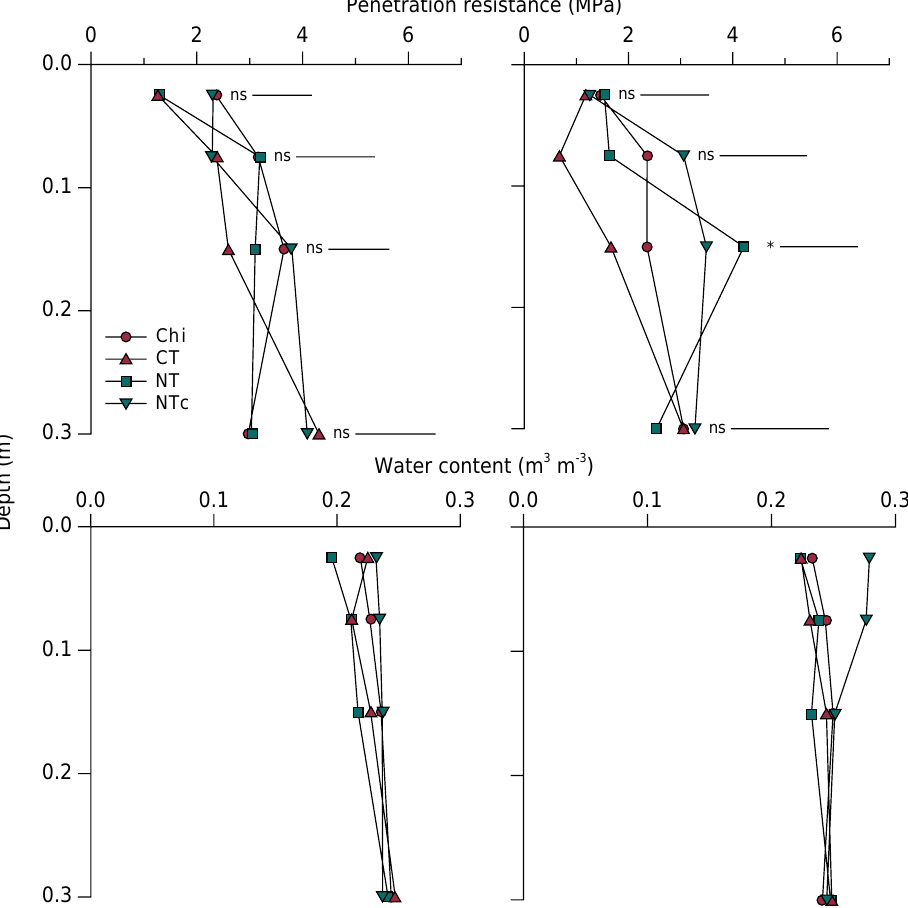
Figure 2. Soil penetration resistance and volumetric water content in inter-row (left) and within row (right) of cassava crop, under chisel tillage (Chi), conventional tillage (CT), no-tillage (NT), and compacted no-tillage (NT C ), one month after cassava planting. *: significant (DMS test, 5 % probability level); ns: not